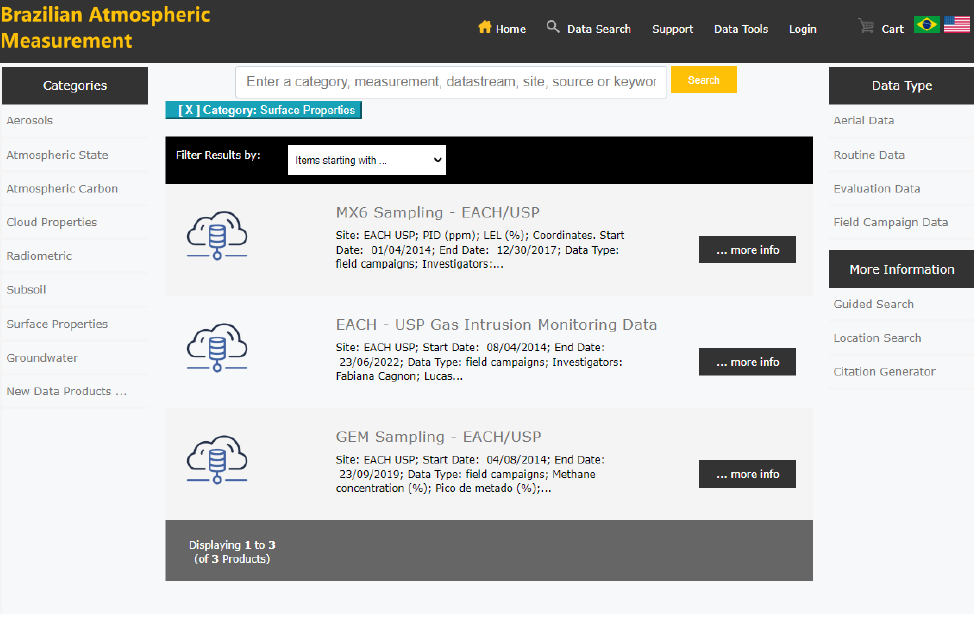
Figure 11. List of data fetched in the Data Discovery